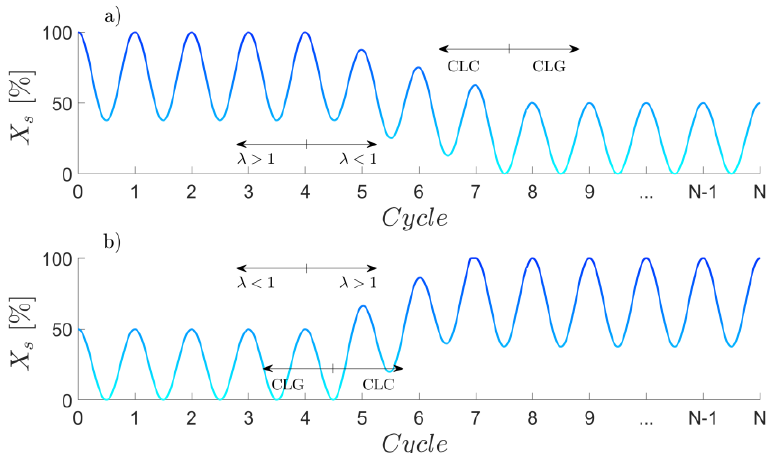
Figure A1. Progression of the OC oxidation degree when shifting from CLC ( λ > 1) to CLG ( λ < 1) mode through variations of the air-to-fuel equivalence ratio. ( a ) Shift from CLC to CLG, ( b ) shift from CLG to